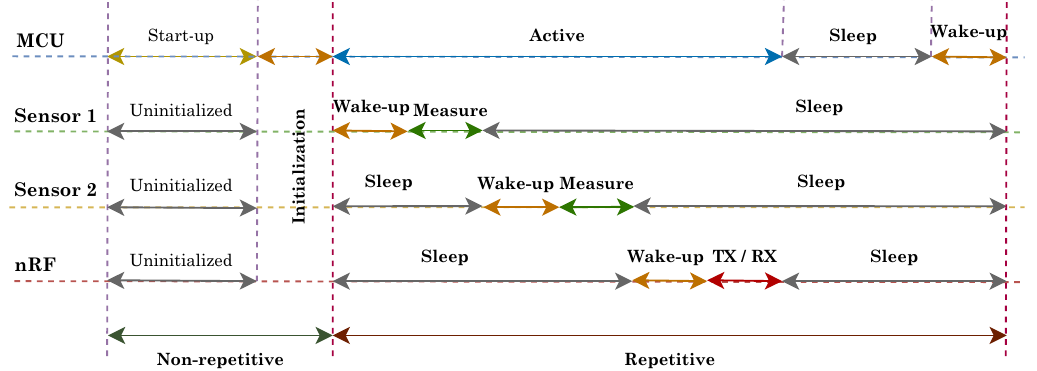
Figure 5. Operational time-line of the parking sensor node (Image not scaled to time).